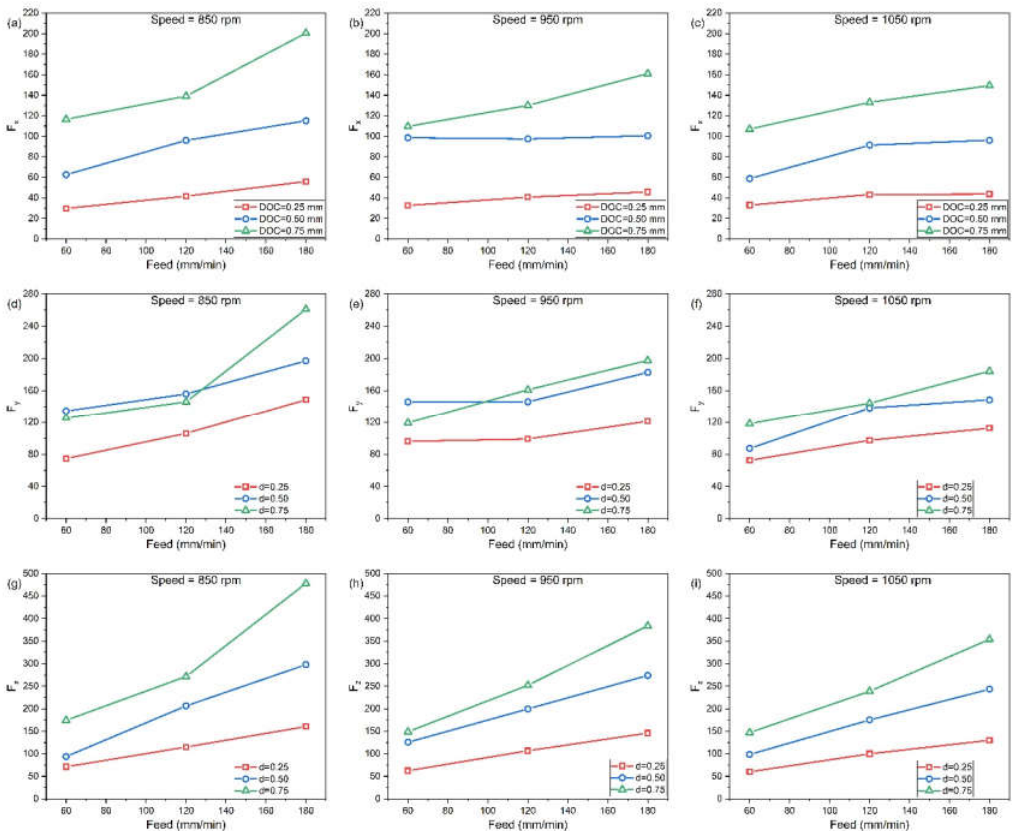
Figure 5. Influence of feed and depth of cut on forces at various speeds. Effect on feed force (Fx) at speed ( a ) 850 rpm, ( b ) 950 rpm ( c ) 1050 rpm; Effect on thrust force (Fy) at speed ( d ) 850 rpm, ( e ) 950 rpm ( f ) 1050 rpm; Effect on cuing force (Fz) at speed ( g ) 850 rpm, ( h ) 950 rpm ( i ) 1050 rpm.